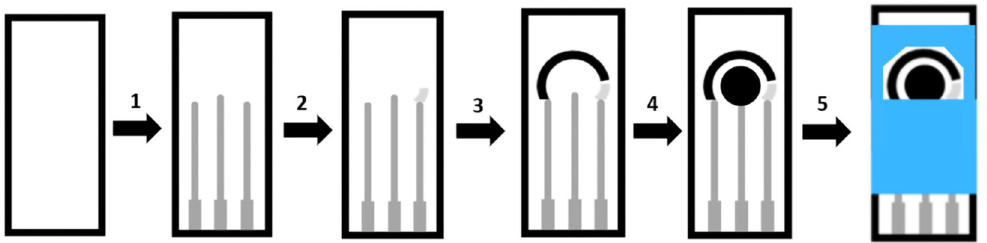
Figure 10. Screen Printing process to produce a biosensor. 1—printing of electrical contacts; 2— printing of RE; 3—printing of AE; 4—printing of WE; 5—printing of insulating layer [118].